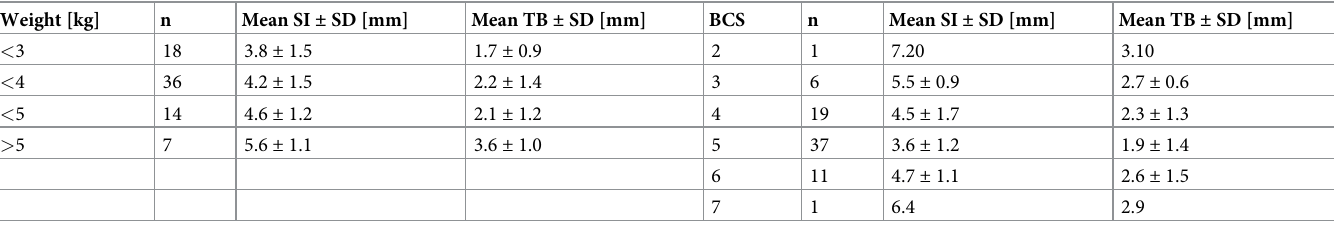
Table 8. Mean values and SDs for SI and TB in cats classified by weight [kg] and BCS. Weight [kg] n Mean SI ± SD